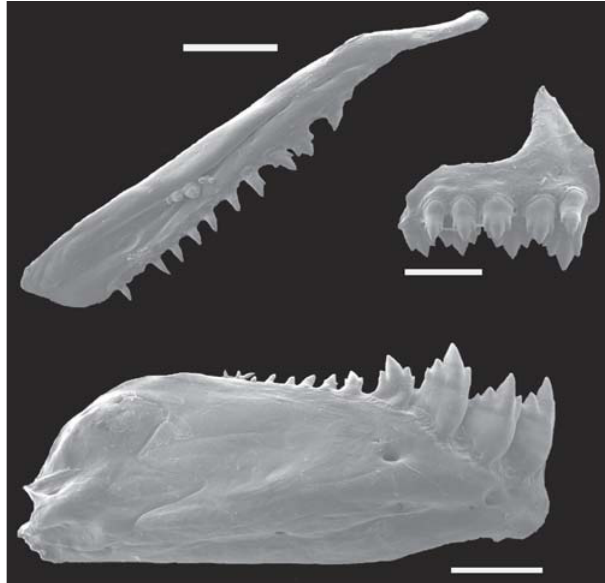
Fig. 3. Hemibrycon divisorensis , MCP 41346, paratype, male, 68.4 mm SL. Scanning electron micrograph of right side upper and lower jaws. The presence of 3-4 teeth in the midlateral of maxilla is an anomaly. Scale bar = 1 mm.